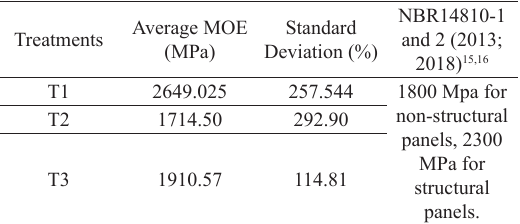
Table 7. Average modulus of elasticity and classification